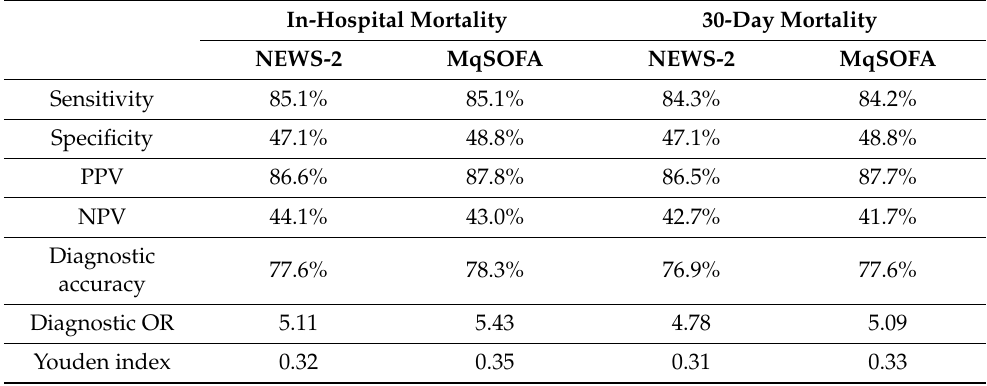
Table 5. Comparison of NEWS-2 and MqSOFA scores according to in-hospital and 30-day